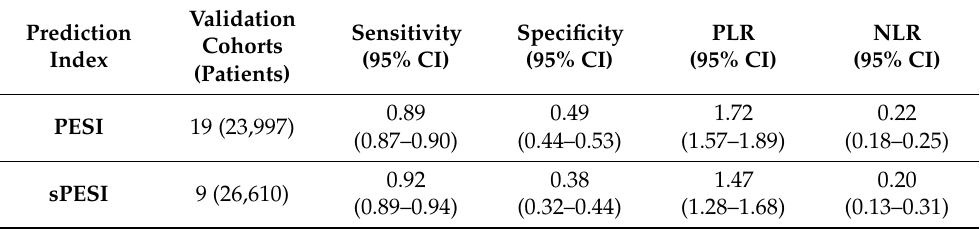
Table 2. Operative characteristics of original and simplified pulmonary embolism severity index for early all-cause mortality